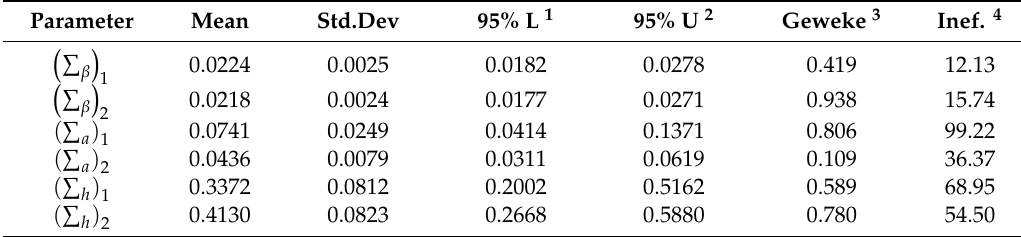
Table 2. Estimation results of selected parameters in the TVP-VAR